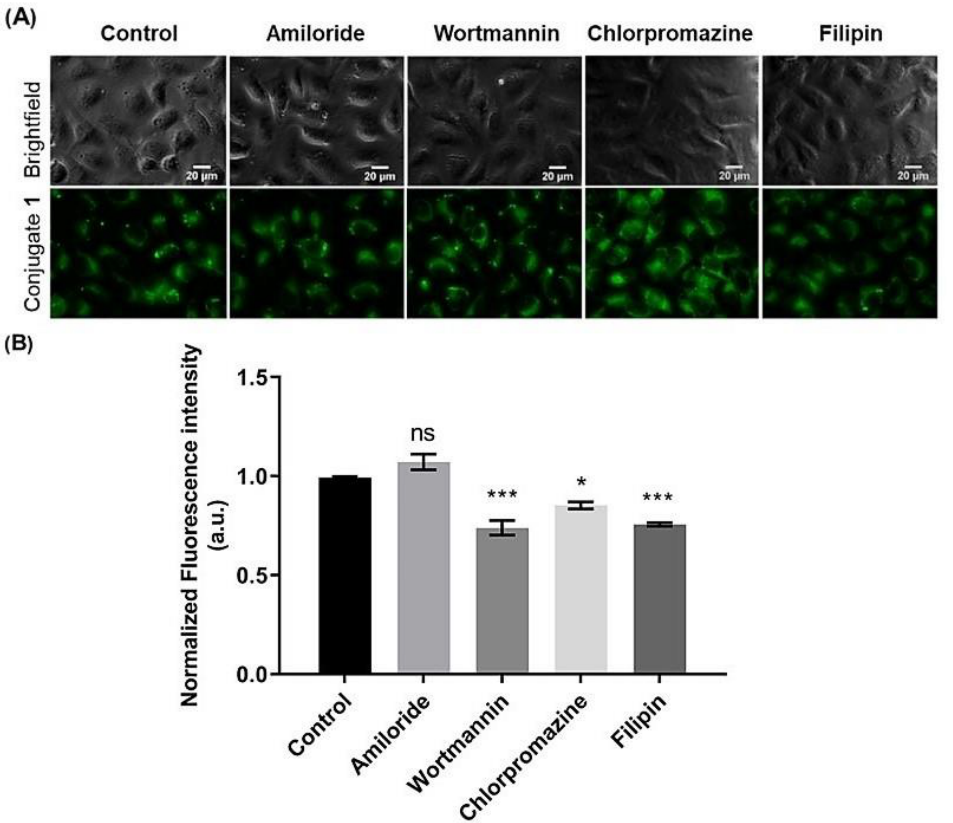
Figure 7 . Inhibition of endocytosis of E2-BODIPY conjugate 1 in MDA-MB-231 cells. Cells were incubated for 1 h without endocytosis inhibitor (control) or with four different endocytosis inhibitors— amiloride, wortmannin, chlorpromazine, and filipin. Then, the cells were incubated for 6 h with 0.5% ( v / v ) DMSO or 50 μM of conjugate 1 and visualized with an inverted microscope. Images of the conjugate channel with blue excitation (green) ( A ), and quantification of the fluorescence intensity ( B ). The images were treated using Image J software version 1.53c (National Institutes of Health (NIH), Bethesda, MD, USA). The fluorescence intensity of the cells was corrected for background fluorescence and normalized with vehicle (DMSO). The control fluorescence intensity was set as 1 for normalization. Results are expressed as the mean ± SEM of two independent experiments. The statistical significance was evaluated by the one-way ANOVA method (ns — not significant, * p ≤ 0.05, *** p ≤ 0.001).